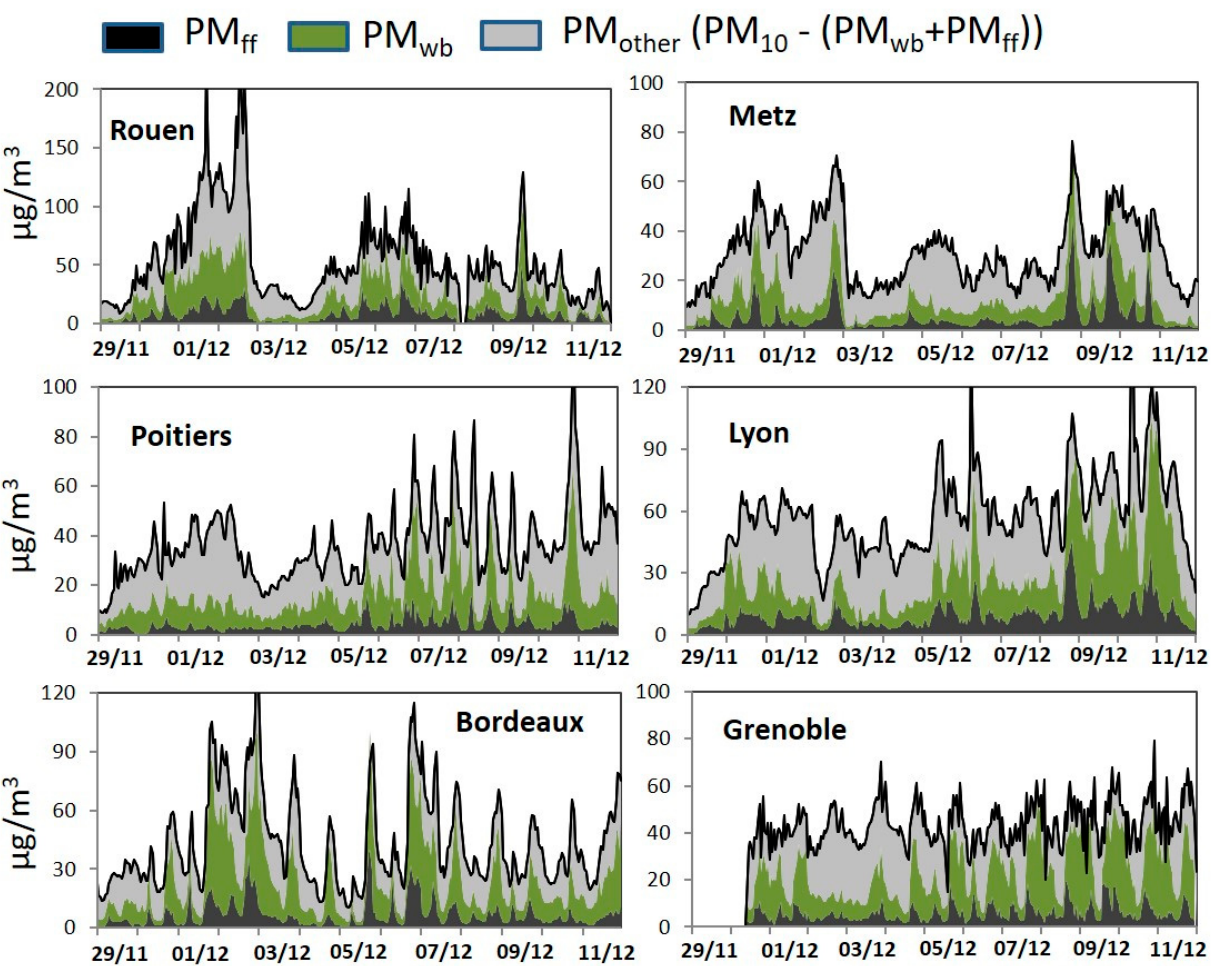
Figure 10. High-time resolution of PM 10 , PM ff , and PM wb variations at six sites of the CARA program during the December 2016 pollution episode.